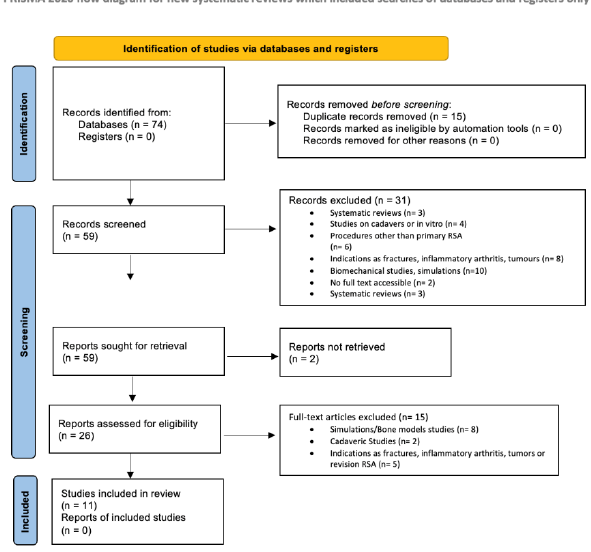
Figure 1. The PRISMA flow-chart of the literature search [32].